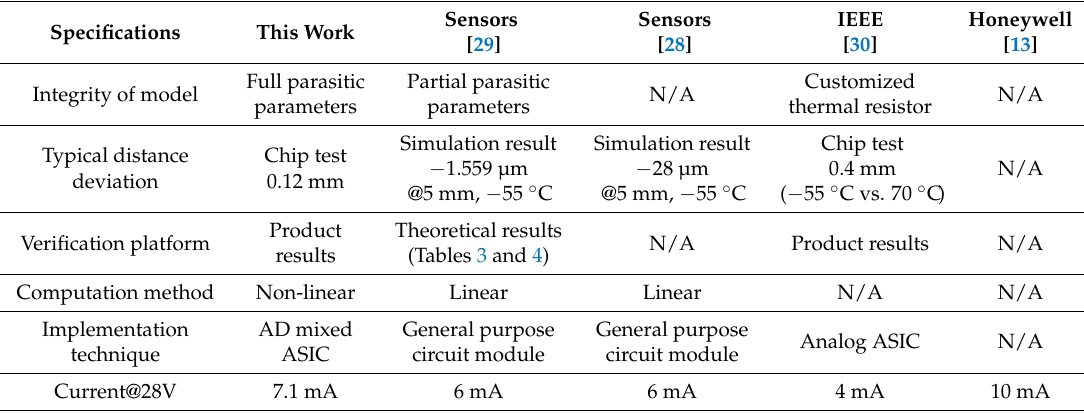
Table 7. Performance summary and comparison with previous